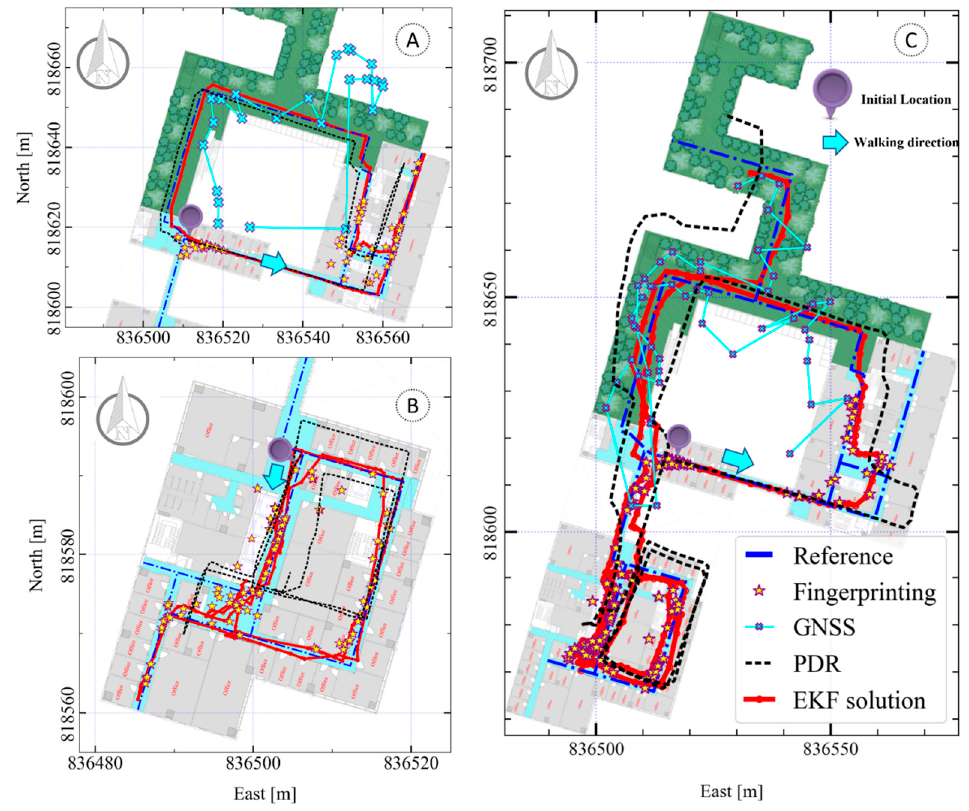
Figure 11. Seamless positioning performance for different tracks A, B, and C.